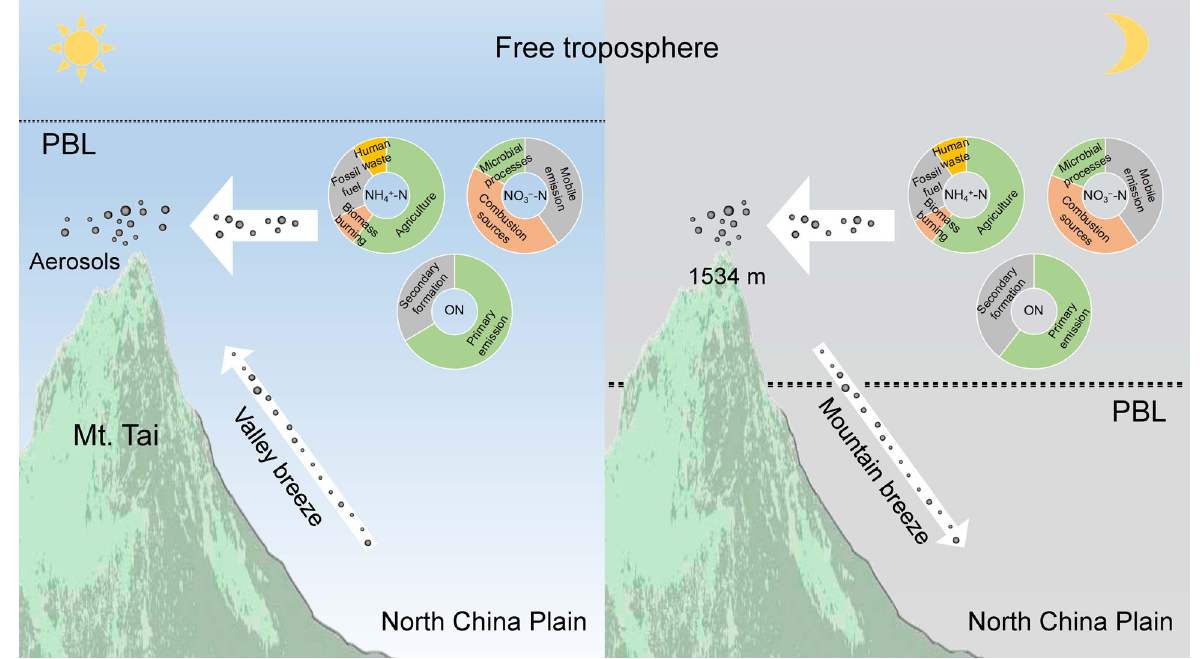
Fig. 4 A conceptual scheme of the sources and transport processes of daytime and nighttime N-containing aerosols over Mt. Tai in spring. Pie charts represent the source apportionment results of N-containing compounds in tropospheric aerosols collected atop Mt. Tai (1534 m a.s.l.). PBL planetary boundary layer; ON organic